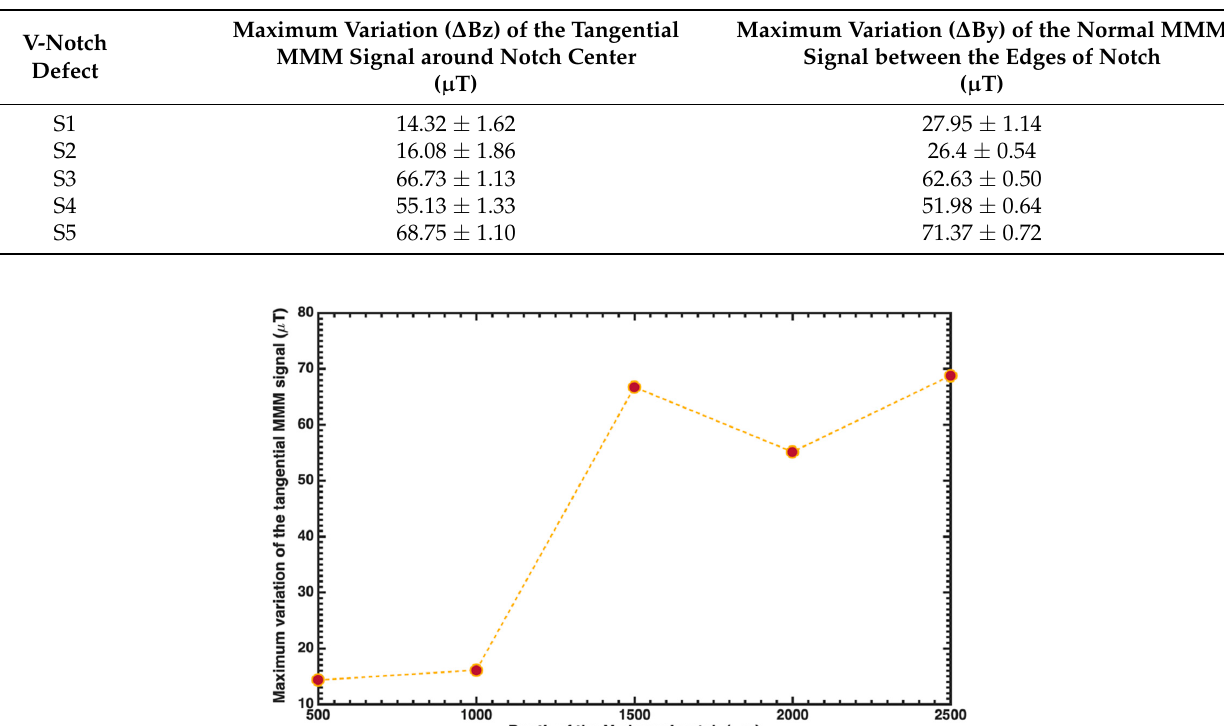
Table 3. Variations of tangential and normal MMM signals around the center and edges of the five V-shaped notches of an ASTM-A36 steel pipe.